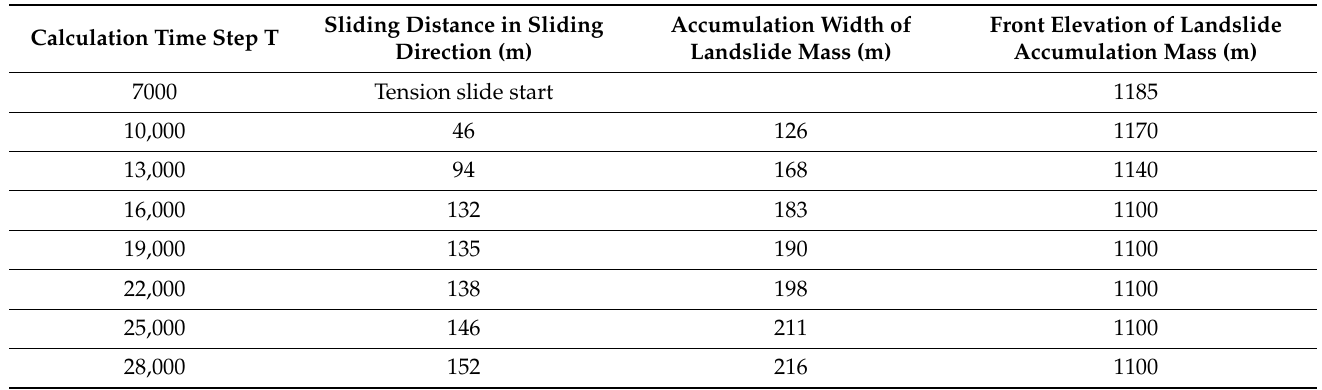
Table 5. Calculation results of damage influence range of 1185 m shear